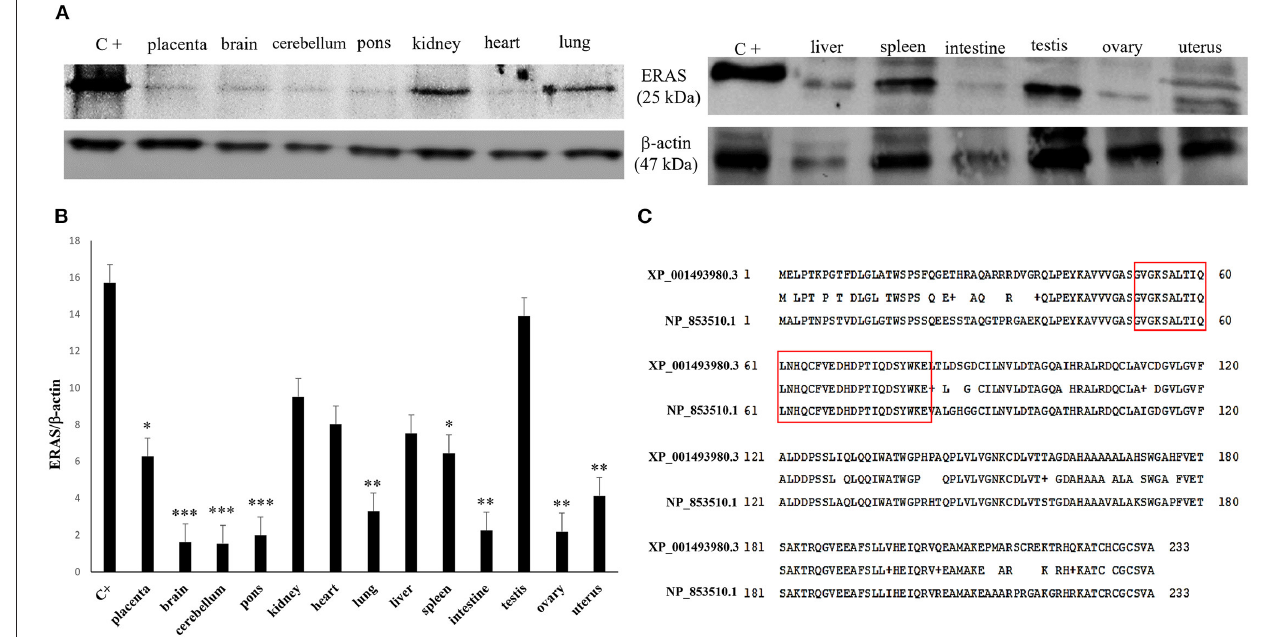
FIGURE 3 | (A) Western blot (WB) analysis of ERAS protein in equine tissues. C + : WB positive control, ERAS HEK 293T cell transient overexpression lysate. An expected ∼ 25kDa band was shown in all samples. Actin was used as loading control. (B) The values of the densitometric analysis were related to the ERAS protein levels in the positive control (* p < 0.05; ** p < 0.01; *** p < 0.001). (C) Alignment between the sequences of the human (NP_853510.1) and equine (XP_001493980.3) ERAS protein showed an 81% identity. The amino acid residues of the epitope against the specific antibody used in the current study have underlined in red. This immunogenic portion of ERAS is composed of 31 amino acid residues (51–81 position) showing a 100% identity between the human and horse epitope.